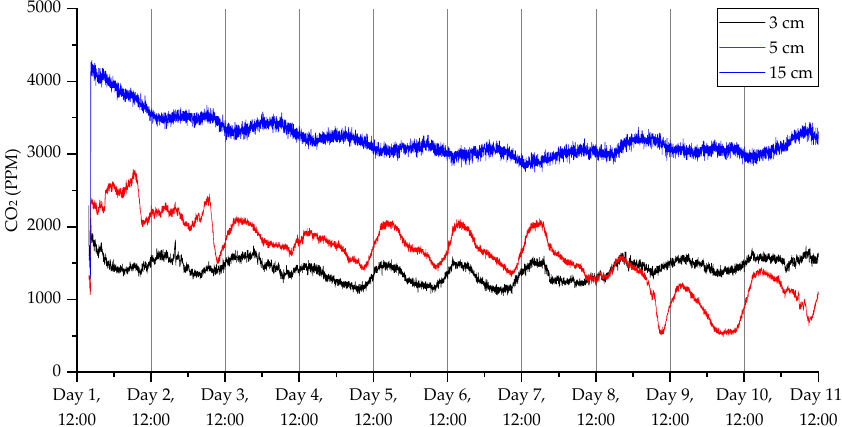
Figure 17. CO 2 measurements for the third deployment in Wellesbourne campus woodland. Data collection commenced on 26 August 2022 at 16:00 (24 h time).